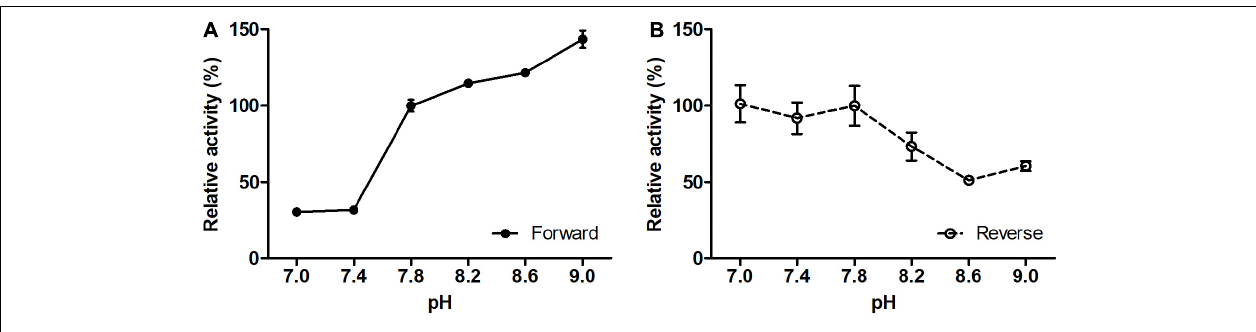
FIGURE 3 | Effect of pH on the forward (A) and reverse (B) reaction rates of recombinant ( S )-3-hydroxybutyryl-CoA dehydrogenase Nmar_1028. (A) 100% activity corresponds to 69.6 ± 2.7 U mg - 1 protein measured with 0.2 mM ( S )-3-hydroxybutyryl-CoA and 0.5 mM NAD + at pH 7.8. (B) 100% activity corresponds to